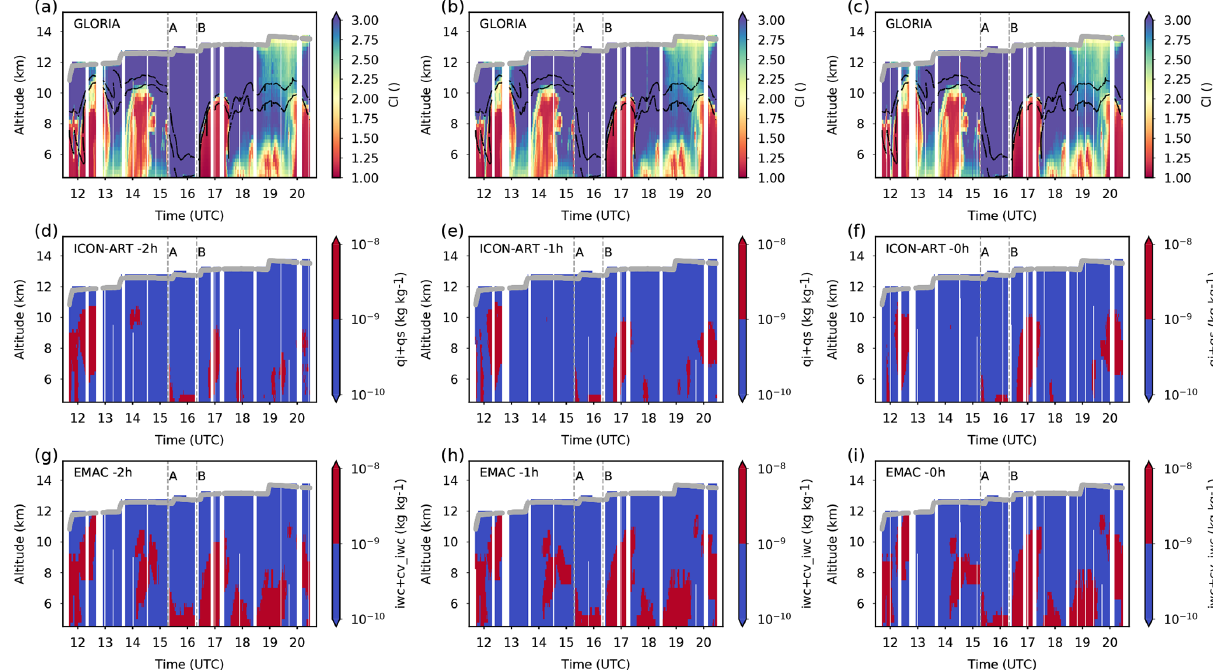
Figure A3. Same as Fig. 5, but model data (ICON-ART and EMAC) have been sampled with a constant time offset of − 2, − 1 and 0h during the interpolation to the GLORIA geolocations along the